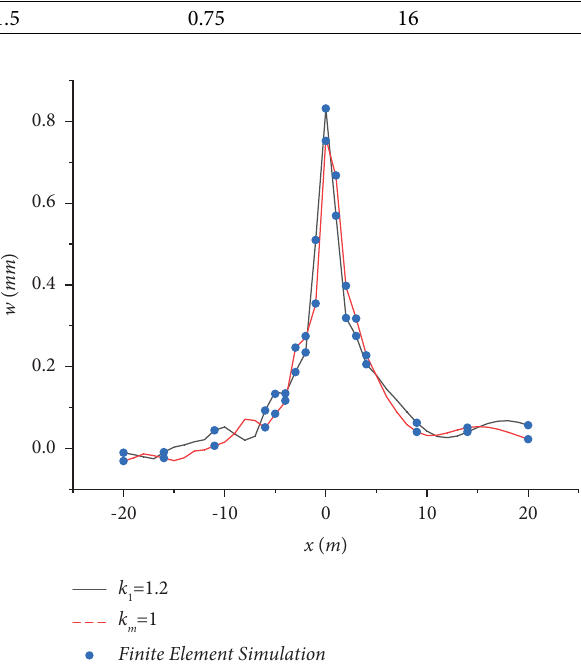
Figure 3: Comparison of the vertical displacement of the plate along the ( x )-direction.